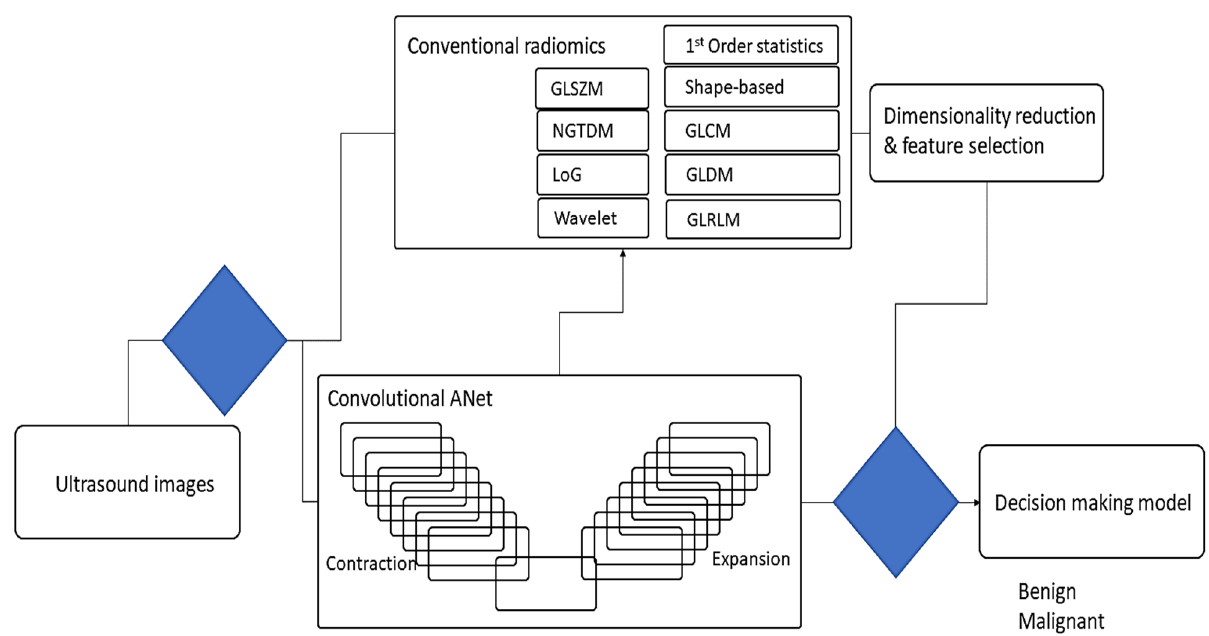
Figure 3. The scheme of the proposed multiple radiomic features generated from ultrasound images to segment and diagnose breast lesions.